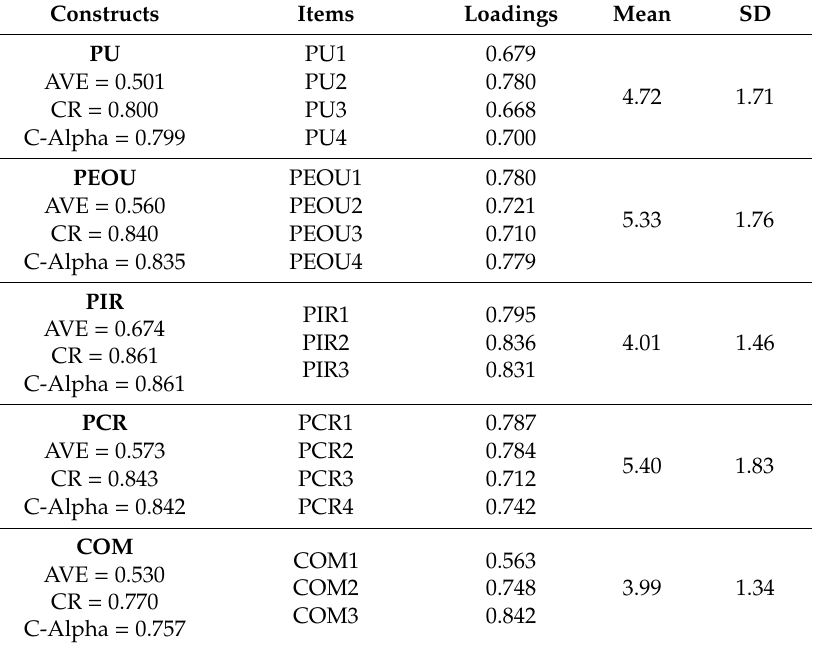
Table 2. The measurement model and cross-loading matrix (Source: Authors’